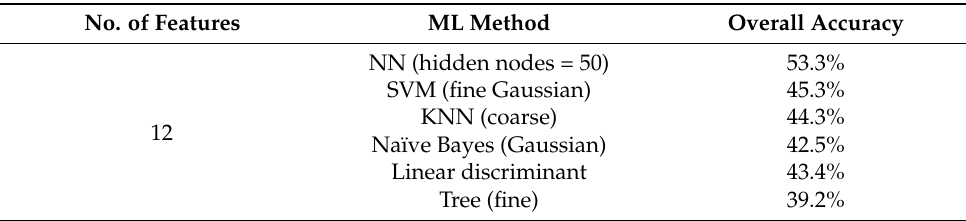
Table 4. Performance of the best OST prediction systems, using radiomic features based on mid- coronal plane and various ML methods.